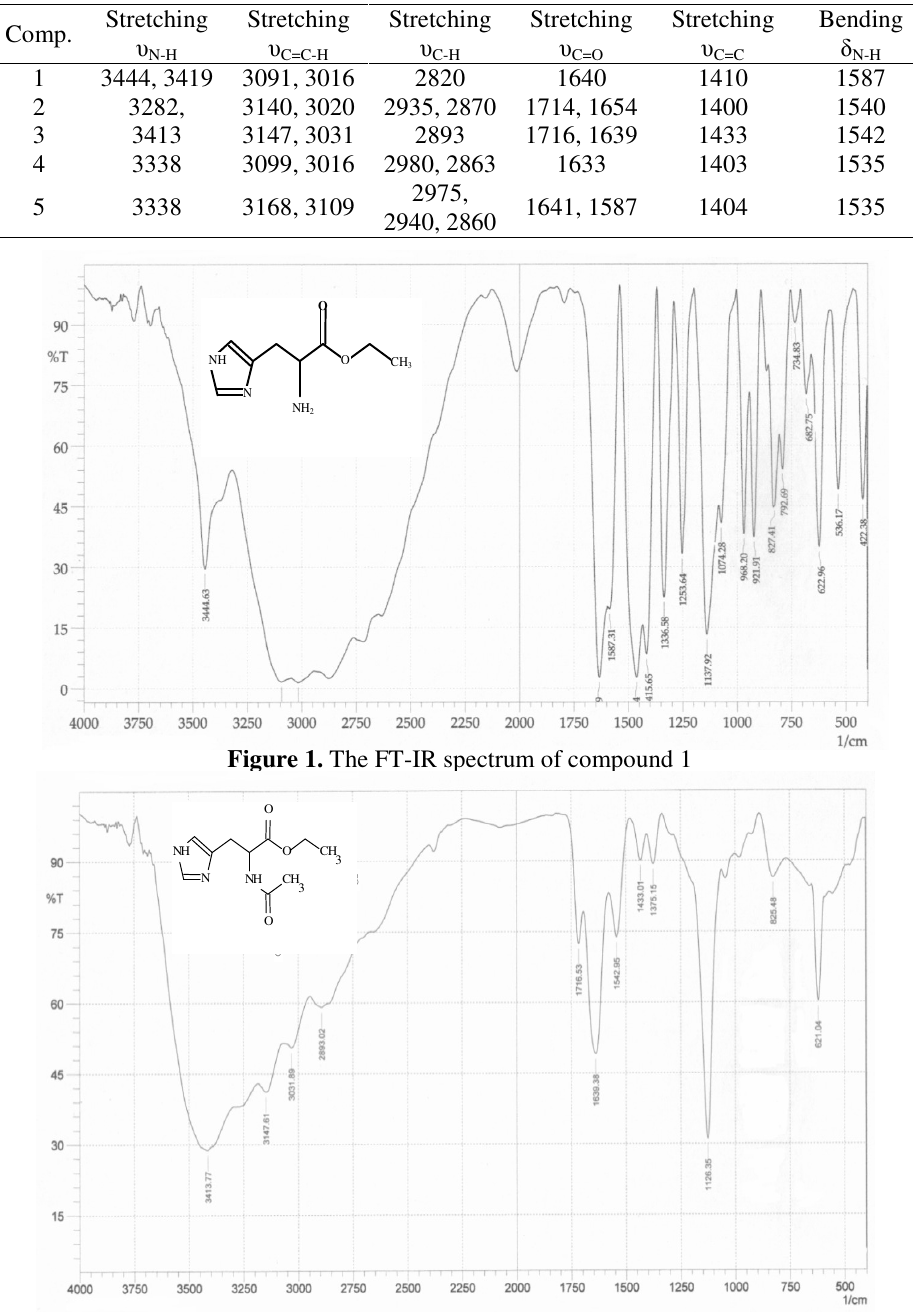
Table 3. Characteristic FT-IR absorptions (cm -1 ) of histidine derivatives Comp.